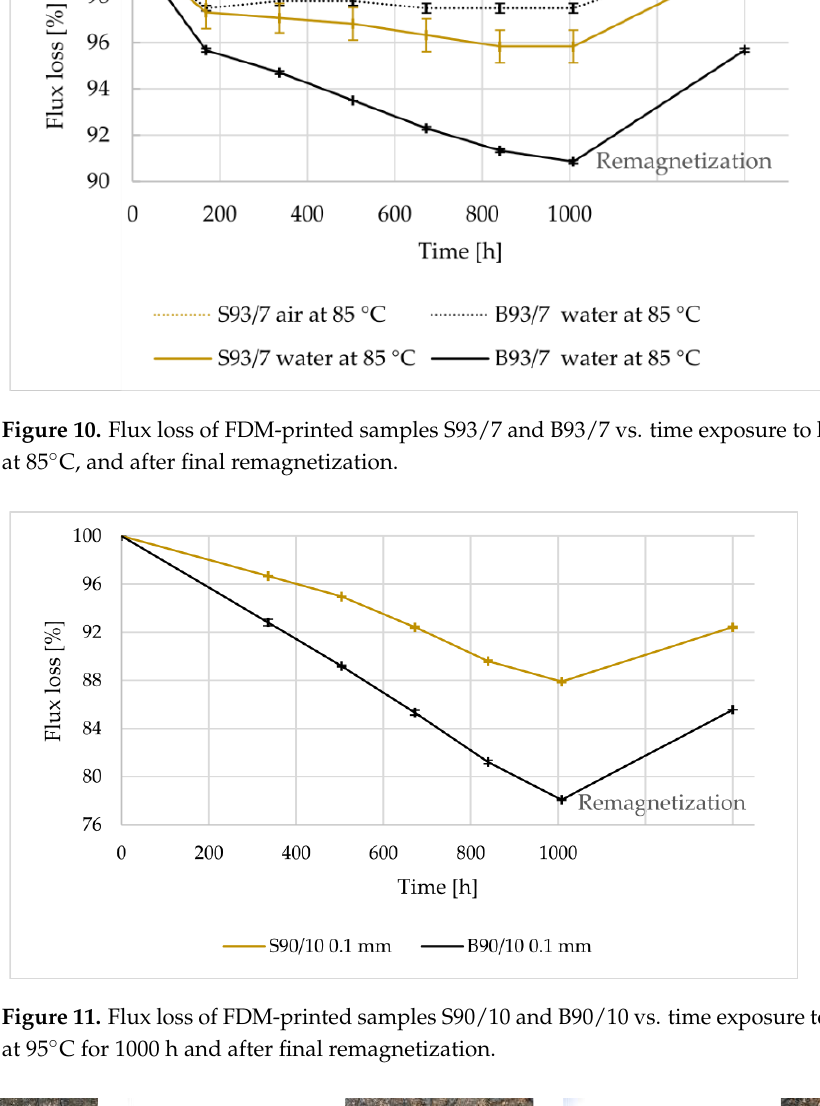
Figure 13. Surface corrosion, cross-section of magnets S90/10 ( a ) and B90/10 ( b ) showing progress of corrosion after immersion in corrosive water at 95 °C for 1000 h.